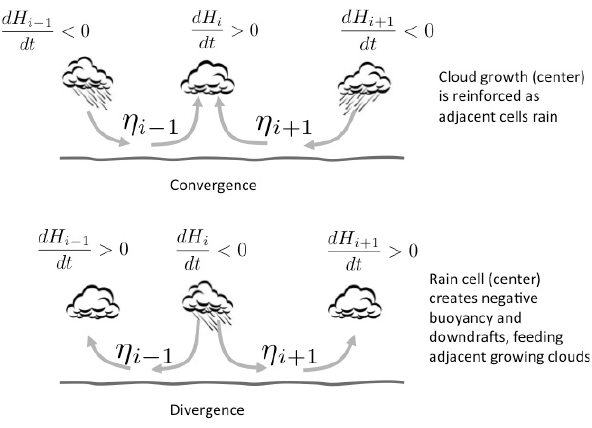
Fig. 1. Schematic showing how each cloud element is coupled to its neighbours via airflow associated with up or downward movement. For simplicity, the cloud elements are depicted as separate clouds, although for stratocumulus clouds, cloud cover might be full. Note that growing clouds are positively buoyant and are associated with upward movement. Raining clouds are negatively buoyant as a re- sult of the evaporative cooling of precipitation. Downdrafts reaching the surface are forced to